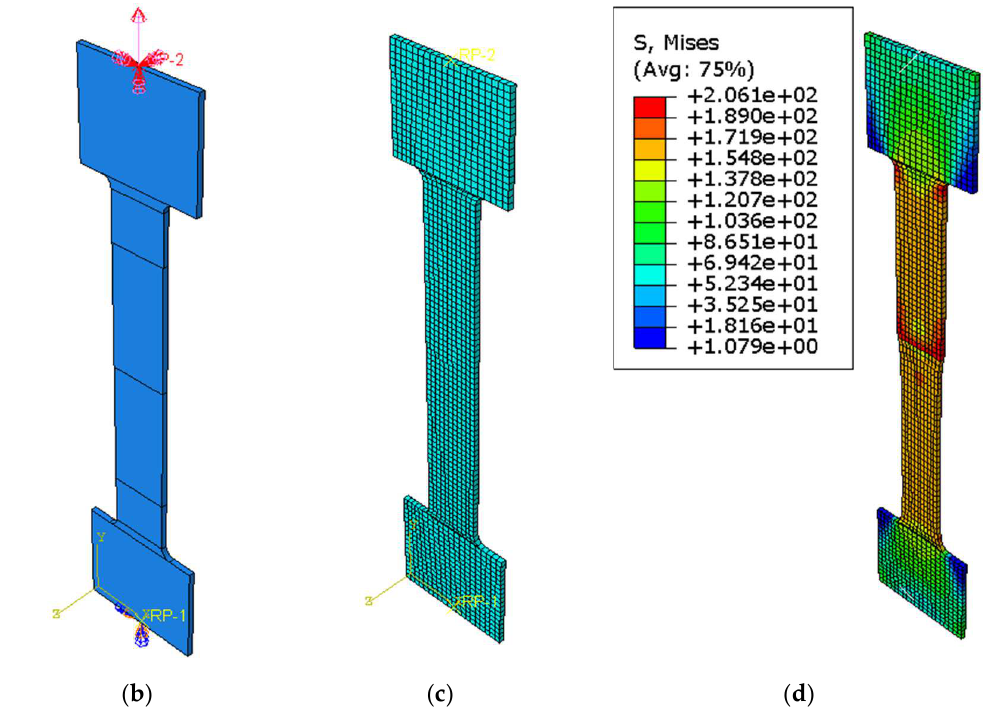
Figure 13. ( a ) Numerical model of the specimen, ( b ) boundary conditions, ( c ) finite element mesh, and ( d ) stress distribution in the specimen.